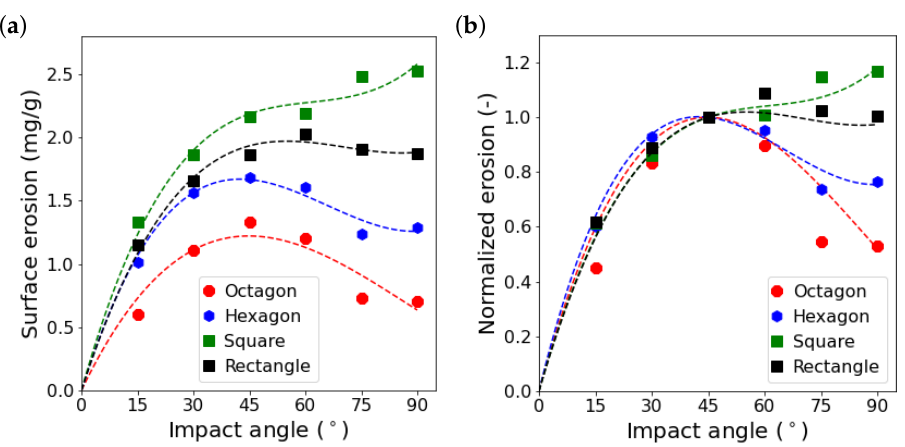
Figure 12. Surface erosion ( a ) and normalized erosion ( b ) for different grain shapes. Surface erosion is divided by the erosion at an impact angle of 45° in order to calculate the normalized erosion. The dashed lines are third order polynomials fitted to the simulated values represented by the symbols.